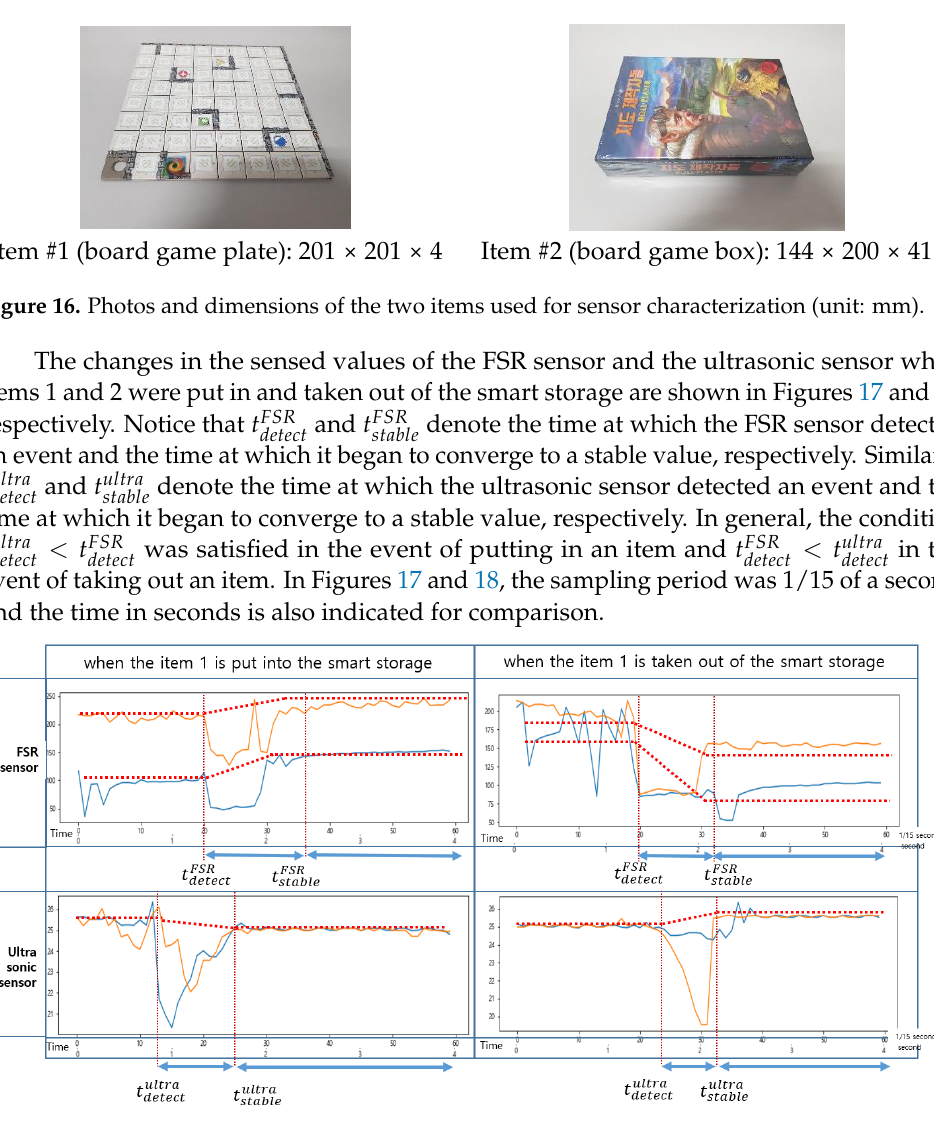
Figure 17. Changes in the sensed values of the FSR sensor and the ultrasonic sensor when item 1 was put in and taken out of the smart storage.